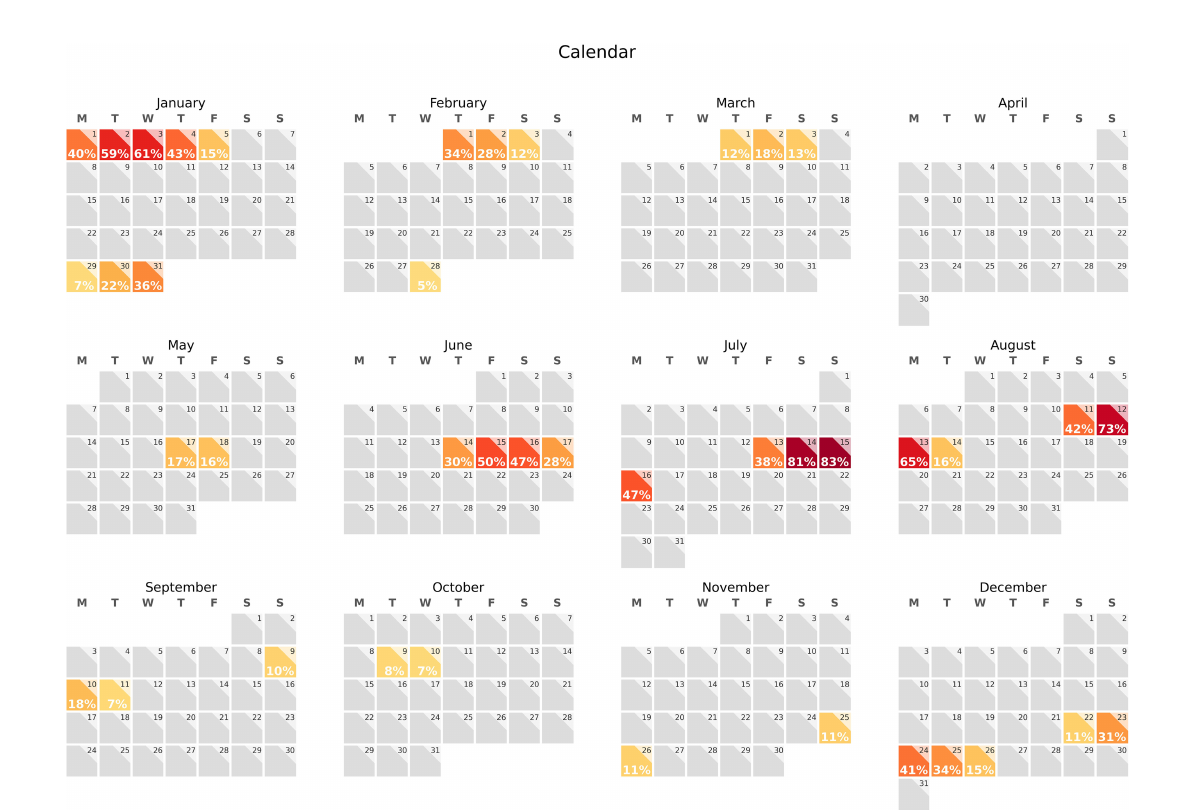
FIGURE 11 An example visualization product of the HTF likelihood for Charleston, SC during 2018. Color shading indicates days that exceed the 5% warning threshold (yellow, near 5%; red, near 100%) with the HTF likelihood